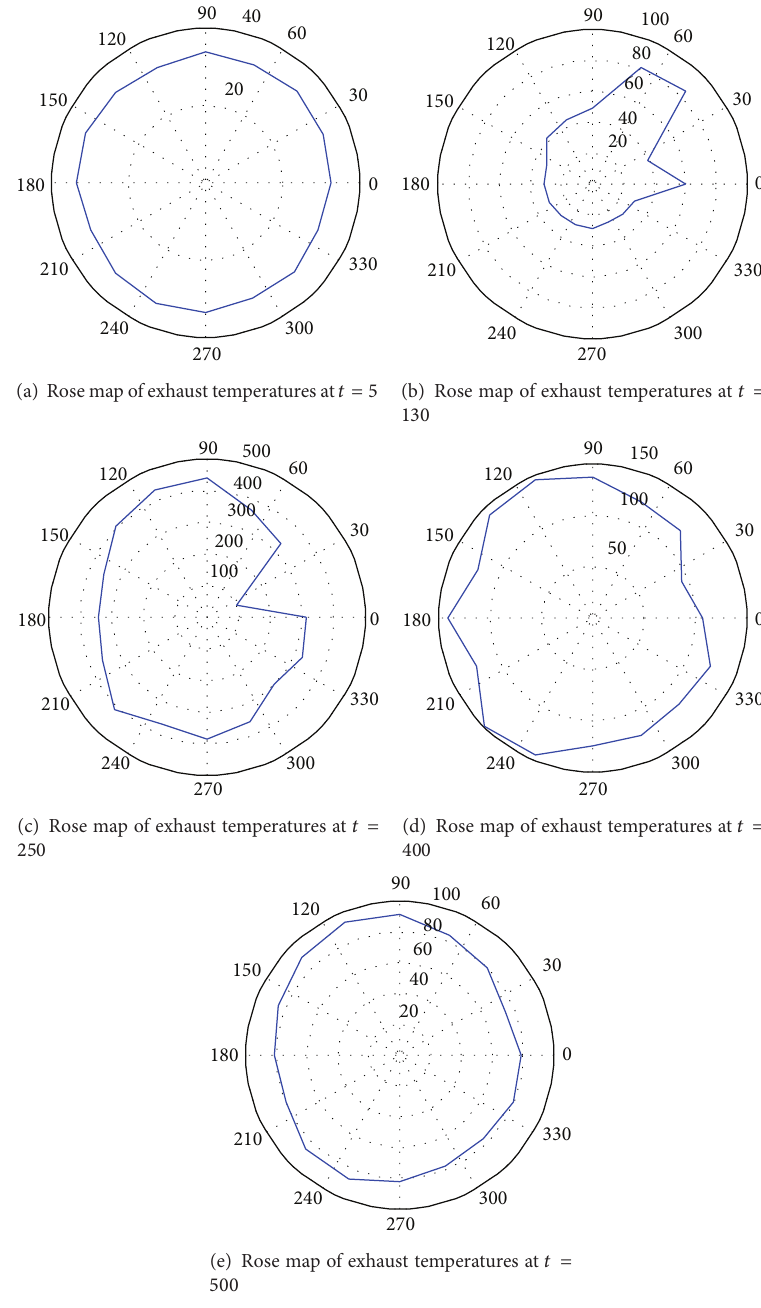
Figure 6: Samples of temperature distribution in different